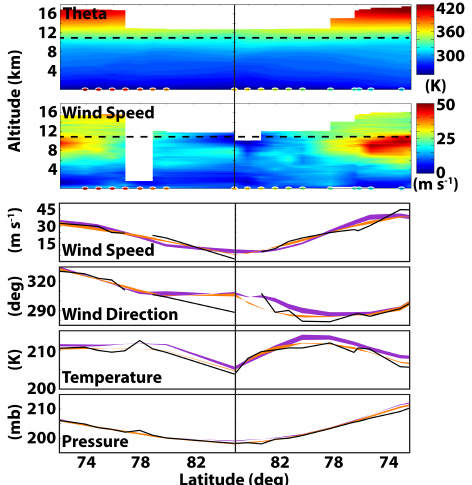
Figure 4. Top panels: potential temperature (K) and wind speed (ms − 1 ) cross sections on 10 March 2011. Colored dots represent dropsonde locations as depicted in Fig. 3. Lower panels, from top to bottom: wind speed (ms − 1 ) , wind direction (deg), temperature (K), and pressure (mb) at 11kmm a.s.l. (dashed line in top cross section) as measured by the dropsondes (black solid lines) and de- picted in the ERA-I (orange) and R-2 (purple) reanalyses at 06:00 and 12:00UTC (shading indicates range between times). Reanaly- sis data are interpolated to the 11km height. The vertical black line in all panels corresponds to the northernmost dropsonde in Fig. 3.